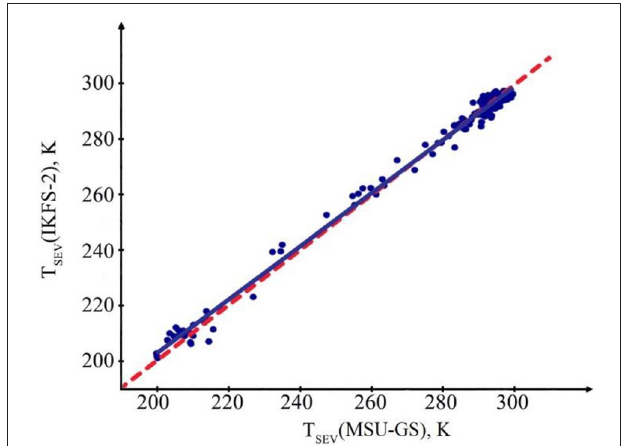
FIGURE 5 | Comparison of SEVERI BT estimates from GEO-GEO and GEO-LEO inter-calibrations, accordingly T SEV (MSU-GS) and T SEV (IKFS-2). In SSP region of Elektro 2, MSU-GS BT were recalculated to T SEV (MSU-GS) by using obtained calibration relationship. In the same region, to obtain estimates T SEV (IKFS-2), the radiance spectra measured by IKFS-2 were convolved with SRF of SEVIRI ch.9 for MSU-GS pixels collocated with central pixels of IKFS-2.